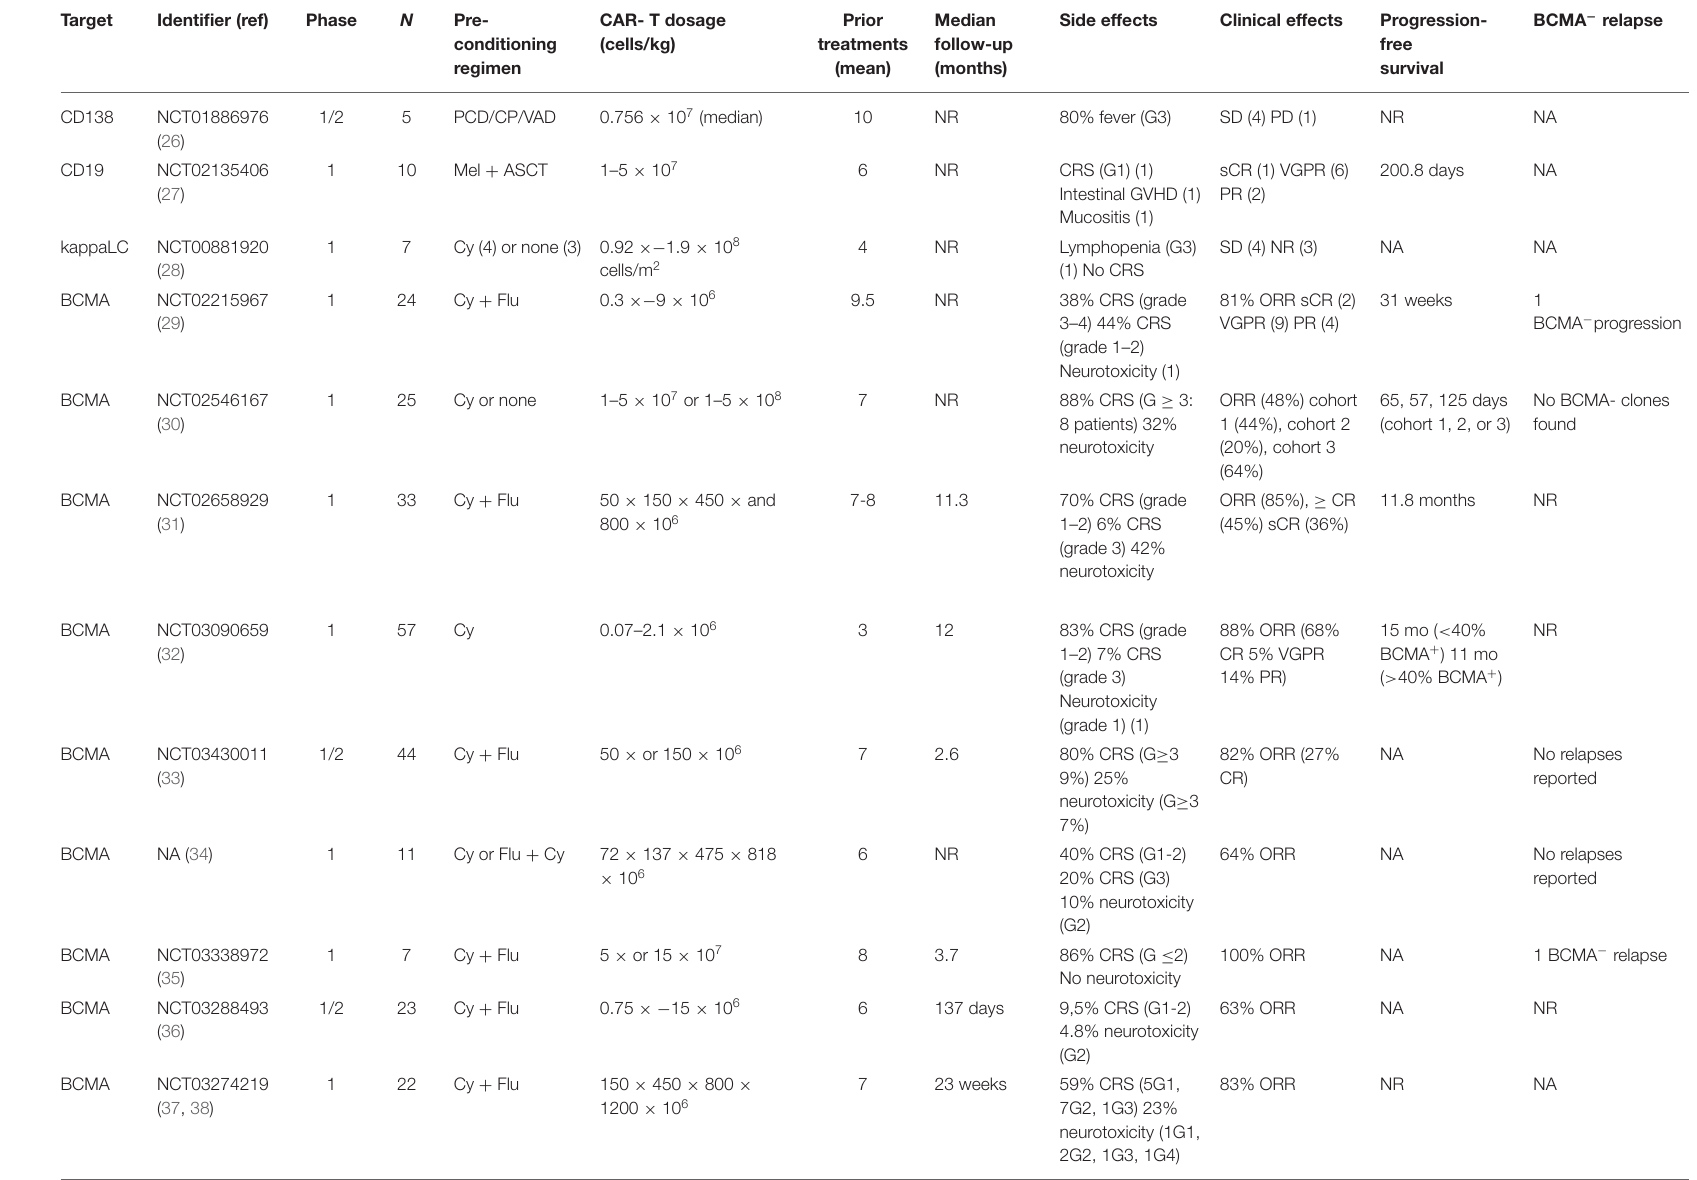
TABLE 2 | Published clinical trials of CAR T-cell therapy in multiple